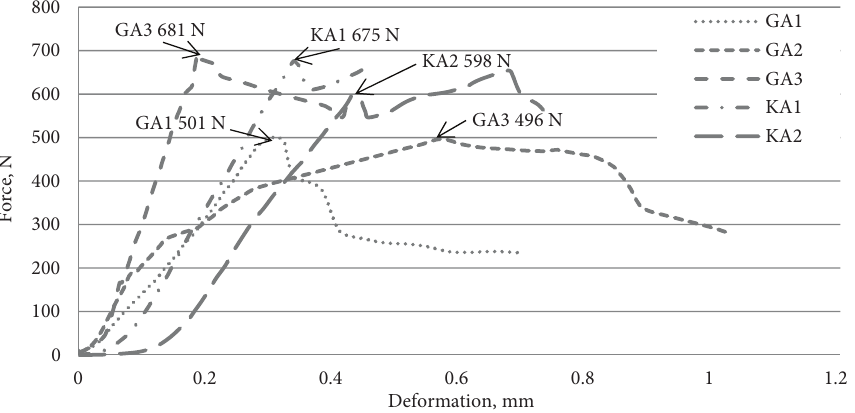
Figure 4. The strength test of experimental manure compost pellets GA1, GA2, GA3, KA1,